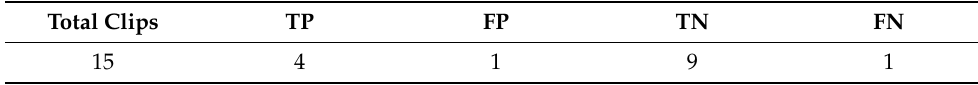
Table 9. Evaluation of crisis video identification on test clips.